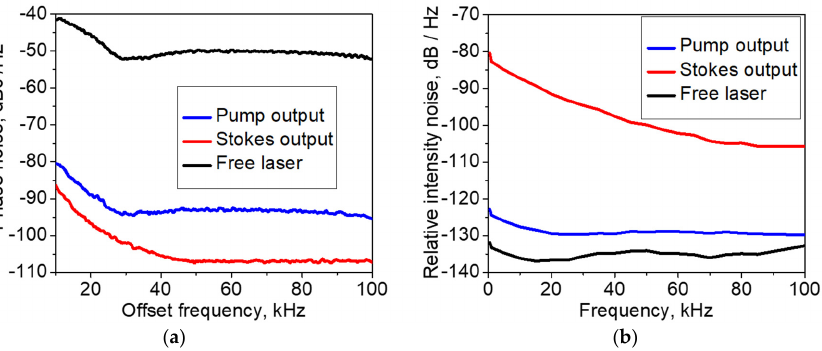
Figure A6. Noise performance of the laser: ( a ) phase noise; ( b ) relative intensity noise (RIN).